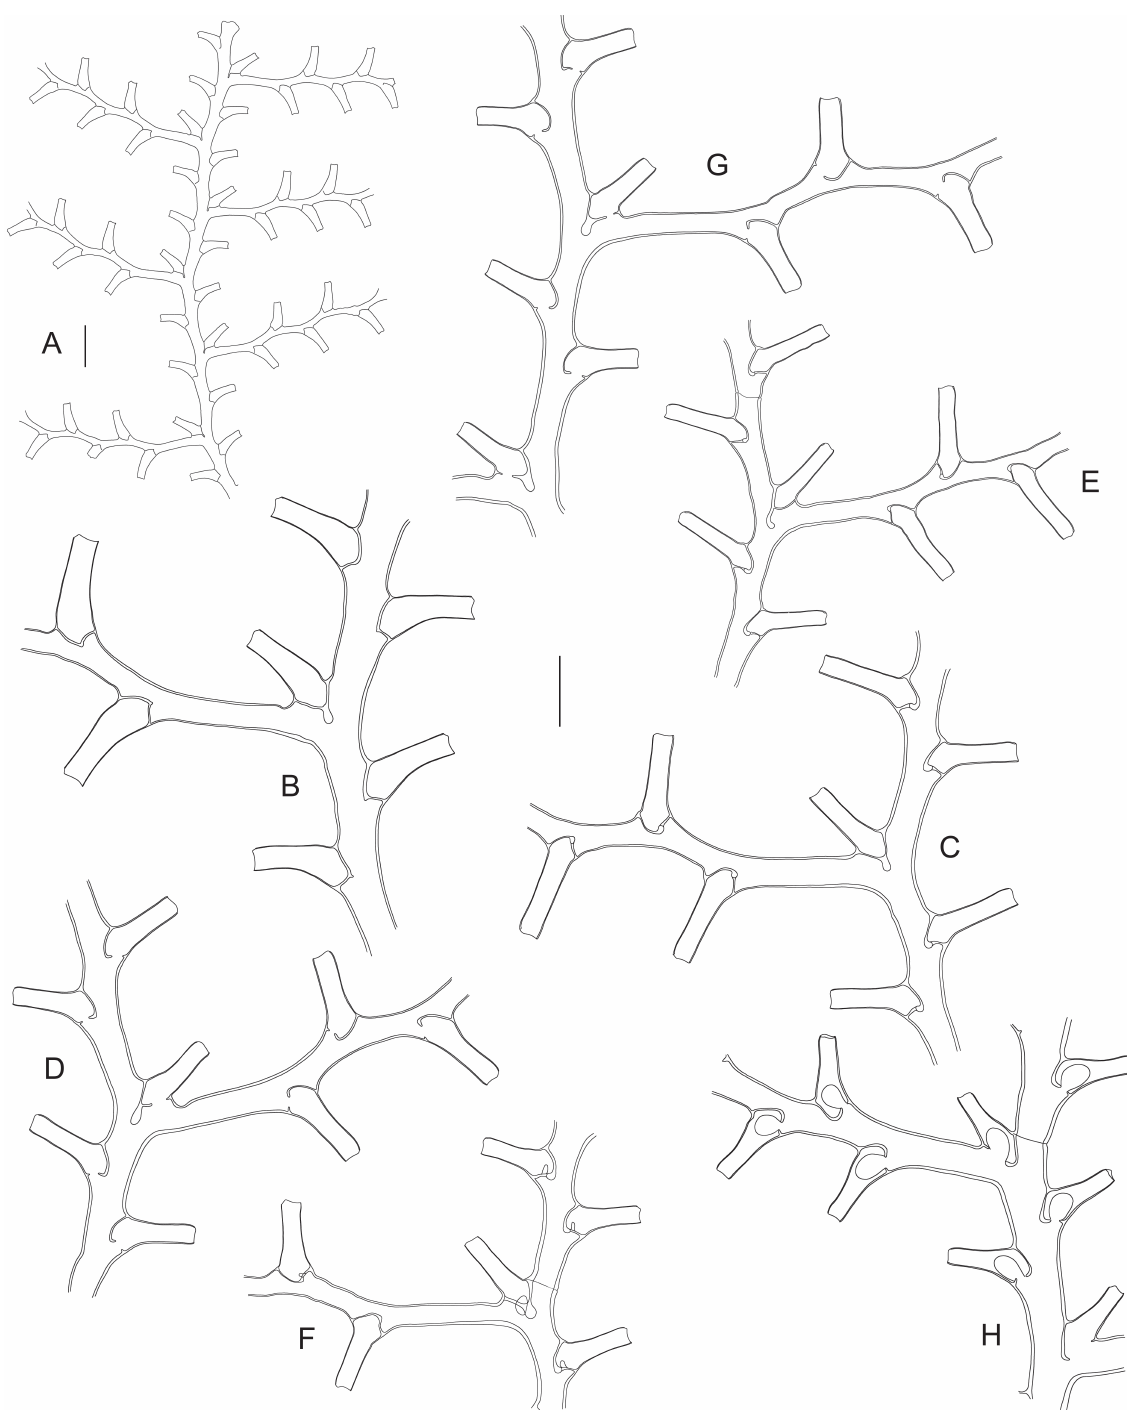
Fig. 5. ― A–B . Gonaxia nova sp. nov. (MUSORSTOM 8, Stn. CP1083). A . Distalmost, monosiphonic part of a colony. B . Portion of stem with basal part of a cladium. ― C–G . Gonaxia scalariformis Vervoort, 1993, portions of stems and basal parts of cladia from BIOCAL, Stn. DW46 (C = colony #1; D = colony #2; E = colony #3), Stn. DW66 ( F ), and NORFOLK 1, Stn. DW1699 ( G ), showing discrete differences in shape and size. ― H . Gonaxia aff. similis Vervoort, 1993 (MUSORSTOM 6, Stn. DW423), portion of stem with cladium. Scale bars: A = 1 mm; B–H =